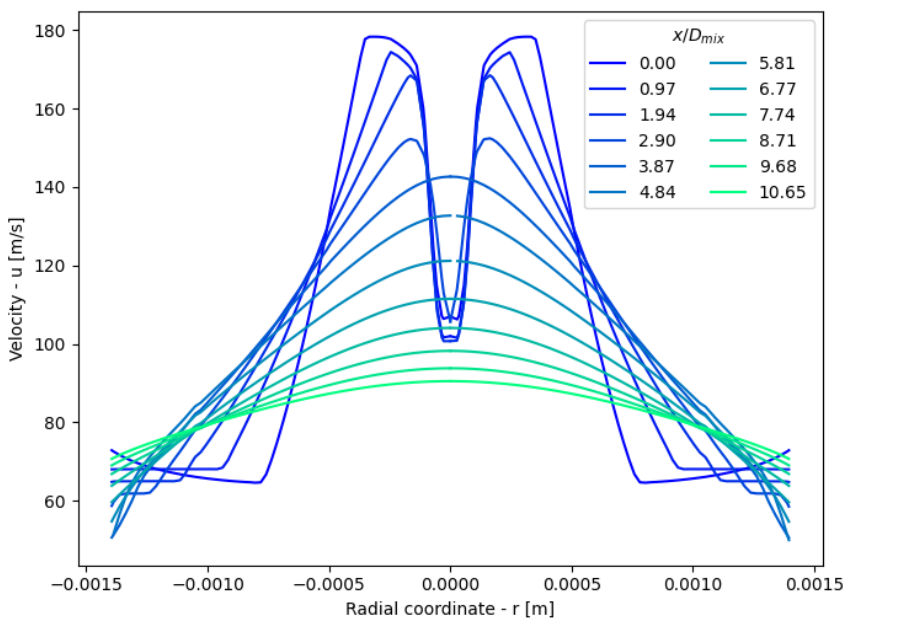
Figure 12. Velocity plot in the y-direction for the ejector without a bypass inlet. The flow is symmetric around the center line in this flow.